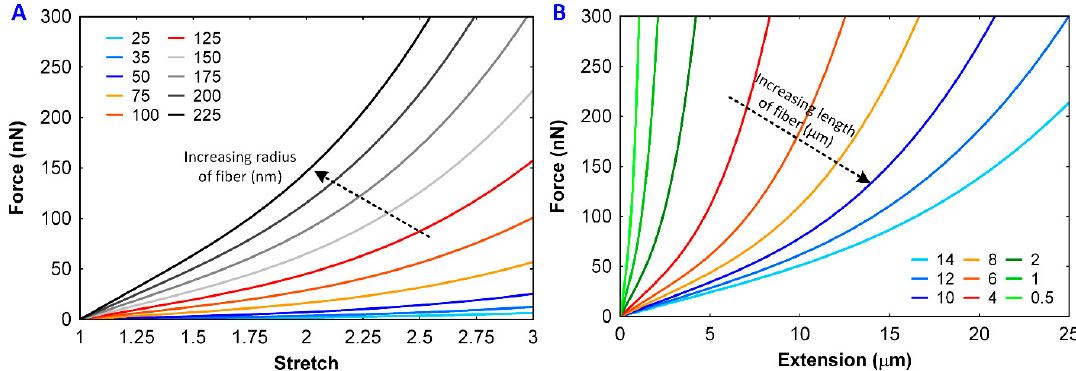
Figure 6. Force–extension curves of fibrin fibers and sensitivity with the ( A ) diameter of the fibrin fibers and ( B ) length of the fibers.